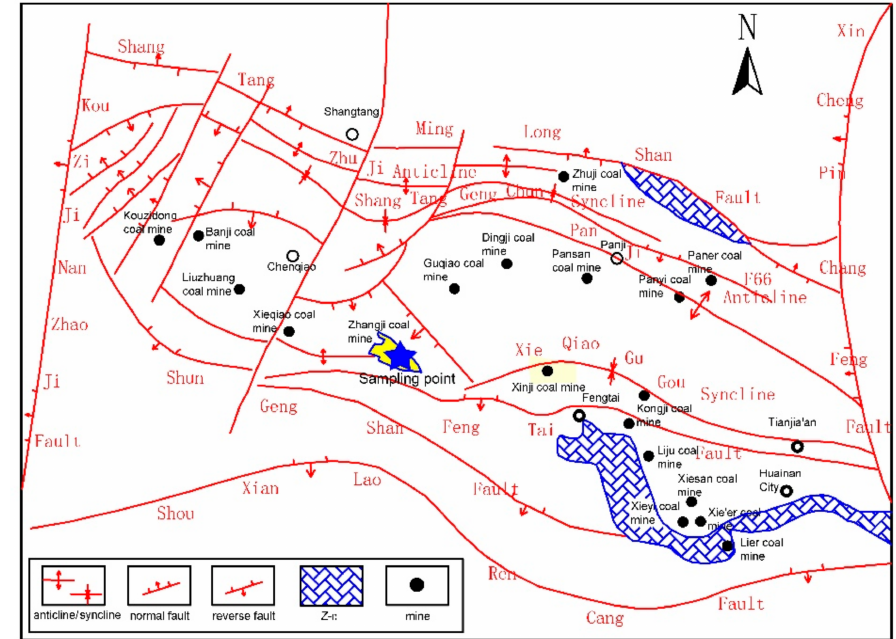
Figure 1. Huainan mining area structure outline map.